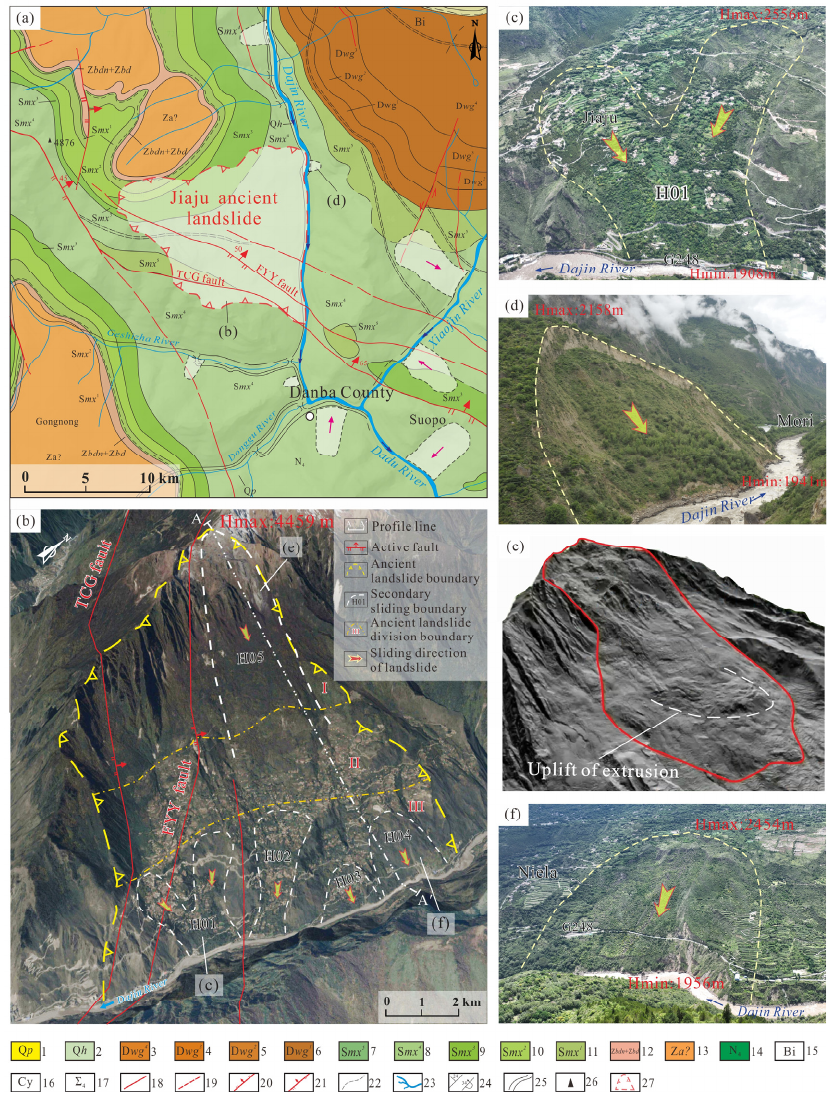
Figure 2. ( a ) Regional tectonic location map; ( b ) remote sensing interpretation of the Jiaju ancient landslide; ( c ) Jiaju landslide UAV image (Mirror to SW); ( d ) Genba landslide (Mirror to SE); ( e ) LiDAR image of Mt.-peak landslide (according to [43]); ( f ) Jiaju landslide UAV image (Mirror to SW). 1—Pleistocene gravel clay; 2—Holocene gravel clay; 3—Mud Quartzite, (carbonaceous) schist, and marble of the fourth rock group of the Weiguan Group of the basin system; 4—Metaconglomerate, schist, and marble of the third rock group of the Weiguan Group of the Devonian system; 5—the Weiguan group of the Devonian system schist and marble of the second rock group; 6—the first rock group of the Weiguan Group of the Devonian Quartzite; 7—the fifth rock group of the Silurian Maoxian Group quartzite and schist; 8—the fourth rock of the Silurian Maoxian Group Formation schist with banded marble; 9—the third group of Silurian Maoxian Group quartzite with schist; 10—the second group of Silurian Maoxian Group schist with marble; 11—the first of the Silurian Maoxian Group Rock formation schist; 12—Sinian Upper Dengying Formation Doushantuo Forma- tion dolomitic marble and schist; 13—Sinian Lower Sinian granulite, conglomerate schist, migmatite; 14—Hercynian unfractionated intrusive rock; 15—biotite belt; 16—lanite belt; 17—undivided ul- trabasic rock; 18—measured fault; 19—inferred fault of unknown nature; 20—measured normal fault; 21—measured reverse fault; 22—inferred geological boundary; 23—river; 24—stratigraphic inclination and dip angle, inversion of bottom layer occurrence; 25—measured geological boundary; 26—elevation point; 27—Jiaju ancient